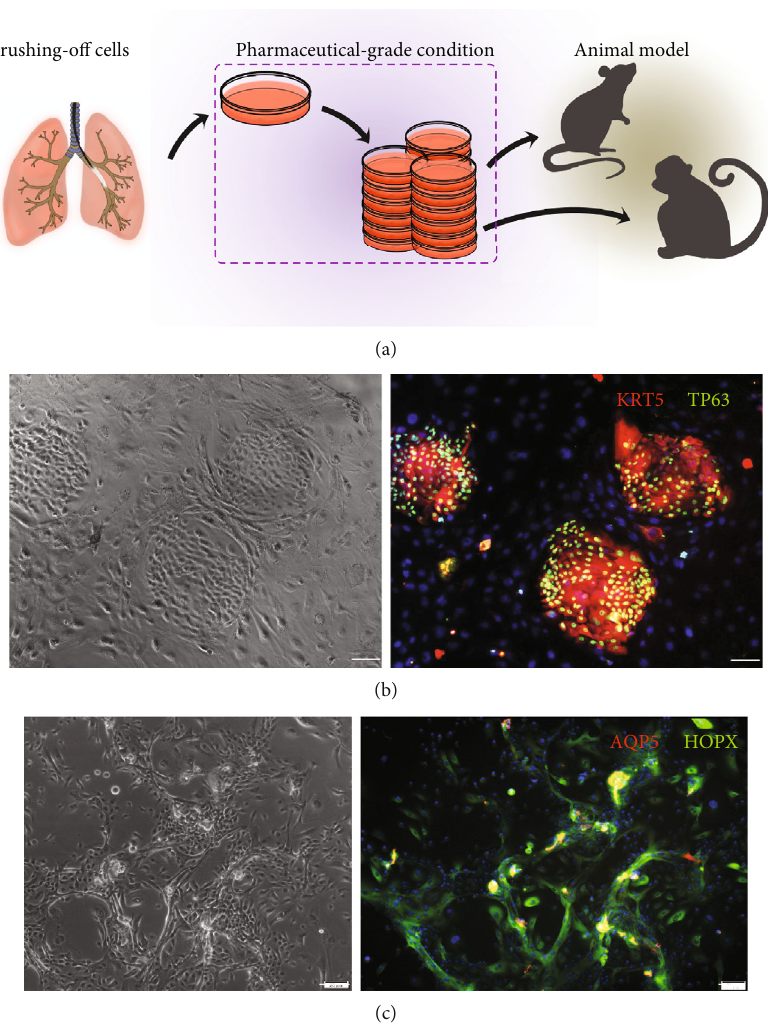
Figure 1: Bronchoscopic isolation of hDASCs from the patient lung. (a) Schematic illustrating the process of clonogenic hDASC isolation and expansion. (b) Clonogenic cells immunostained with hDASC markers KRT5 and P63. (b1) Bright- fi eld imaging. (b2) Immuno fl uorescence imaging. Scale bar, 100 μ m. (c) Di ff erentiation culture of hDASCs in the monolayer on day 7. (c1) Bright- fi eld imaging. (c2) Immuno fl uorescence imaging. Scale bar, 50 μ